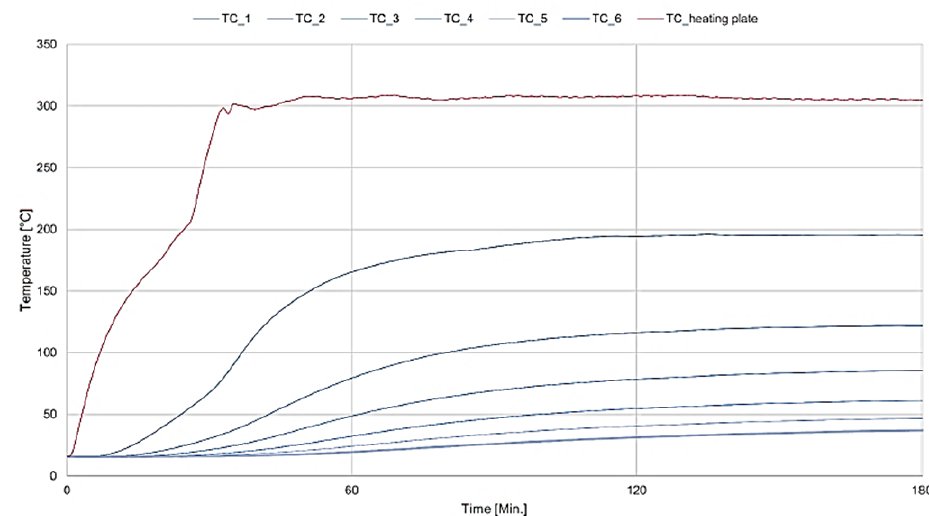
Figure 14. Temperature development for individual sensors.